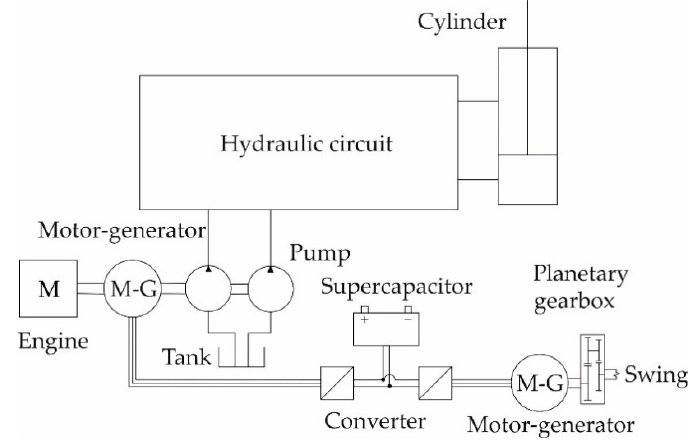
Figure 4. Hybrid system of Komatsu Ltd.